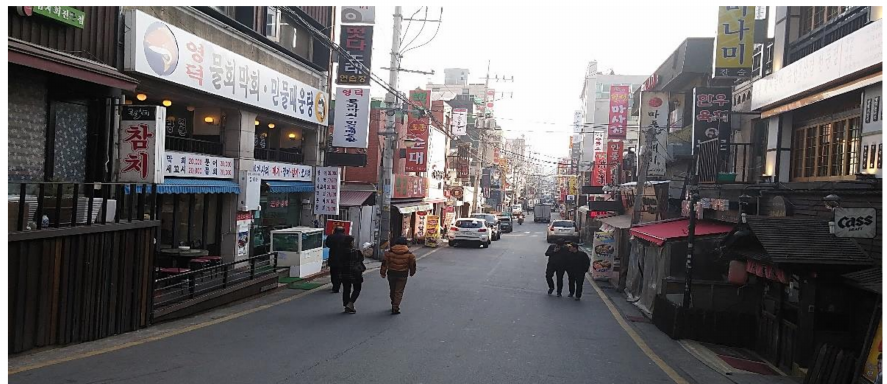
Figure 5. Picture and statement depicting various eateries along a